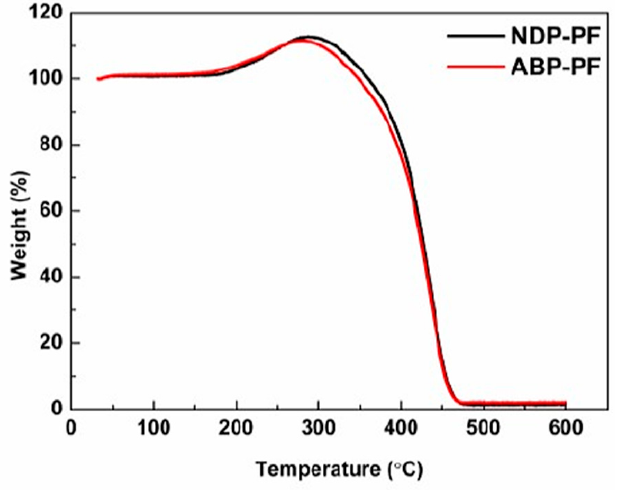
Figure 6. Thermogravimetric (TG) curves of NDP-PF and ABP-PF during stabilization process in air atmosphere. Table 3. Oxidation and carbonization properties of pitch fibers.